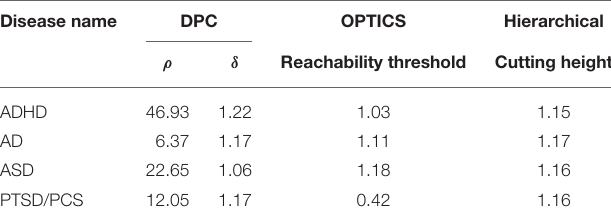
TABLE 5 | Estimated optimal values of each input parameter in clustering for clinical vs. connectivity comparison. Disease name